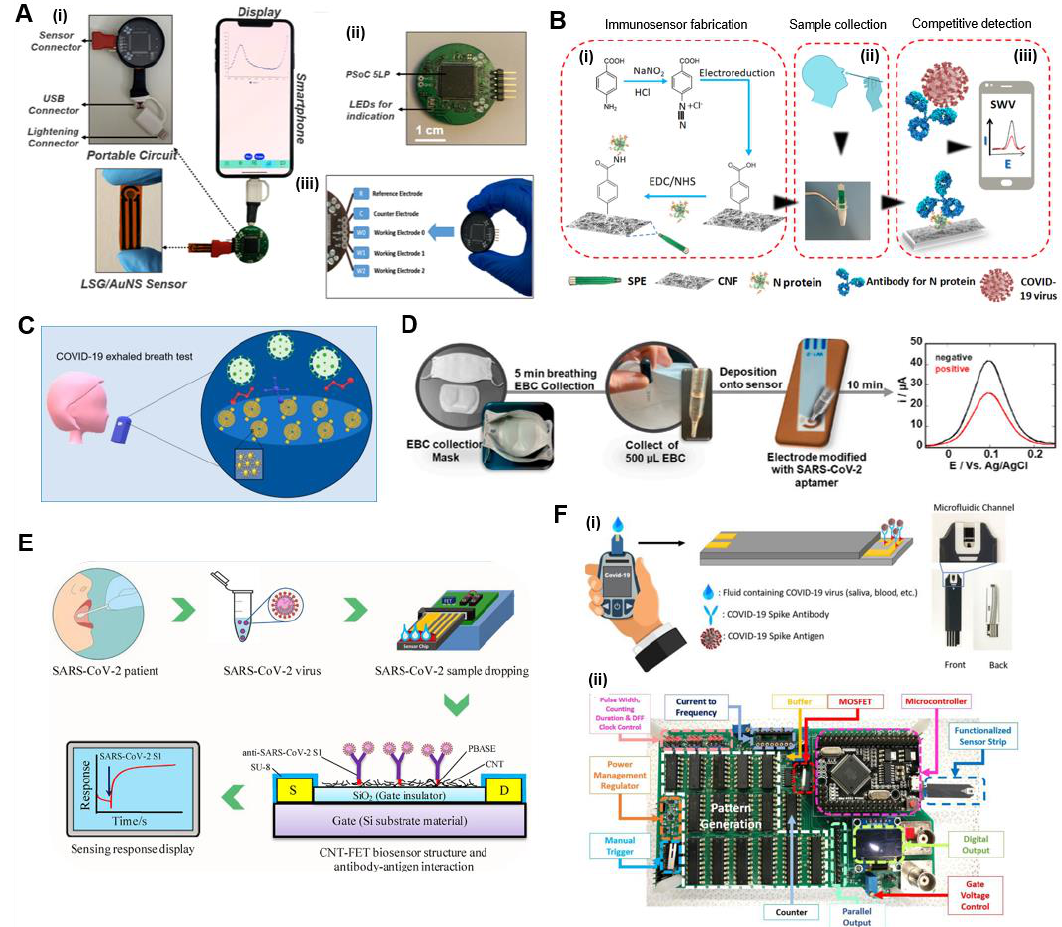
Figure 3. Chip-based potential electrochemical immunoassays—Part 1. ( A ) A laser-scribed graphene (LSG)-based disposable electrochemical biosensor for SARS-CoV-2 S protein detection. (i) Photographs of integrated portable hand-built POC potentiostat linked to a smartphone via a USB-C connection to enable signal readout using KAUSTat software. (ii) Image of the potentiostat. (iii) Pinpointing of the device components. Reproduced with permission from [96]. Copyright 2021, American Chemical Society. ( B ) Schematic presentation of cotton-tipped electrochemical im- munosensor for SARS-CoV-2 N protein detection. (i) Carbon nanofiber electrode modification using